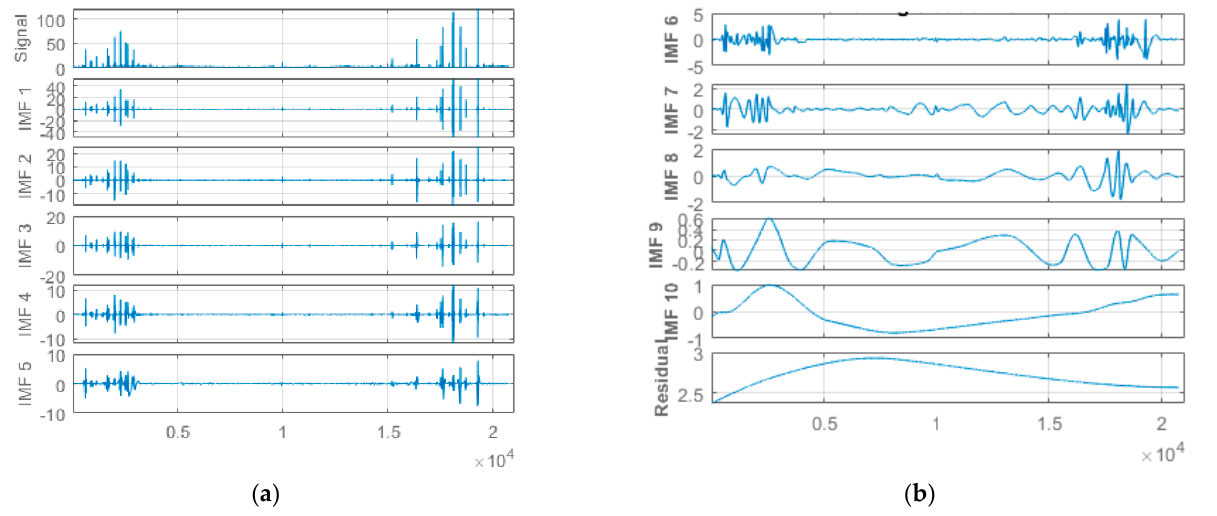
Figure 8. ( a ) One to five of 10 different IMFs for the turbidity data signal. ( b ) Six to ten of 10 different IMFs and the corresponding residual for the turbidity data signal.